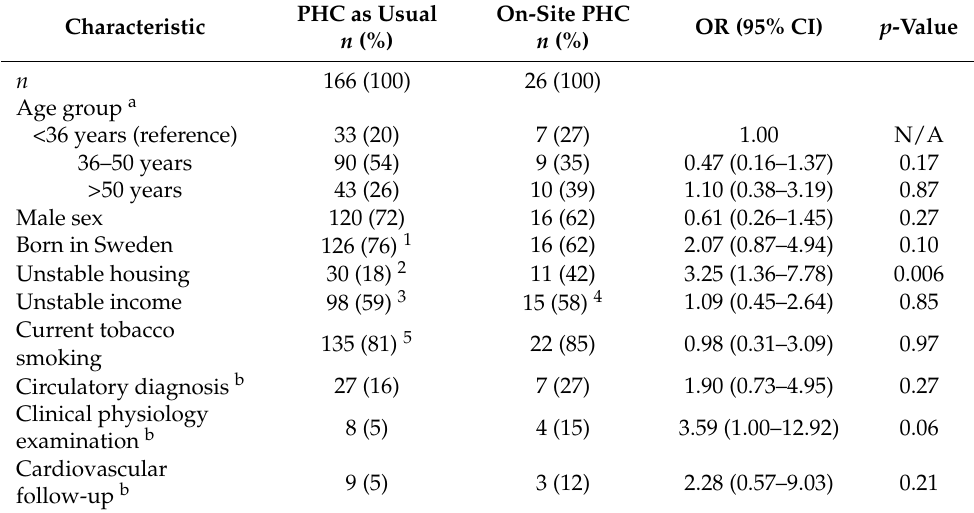
Table 3. Comparison of patients with and without access to on-site primary health